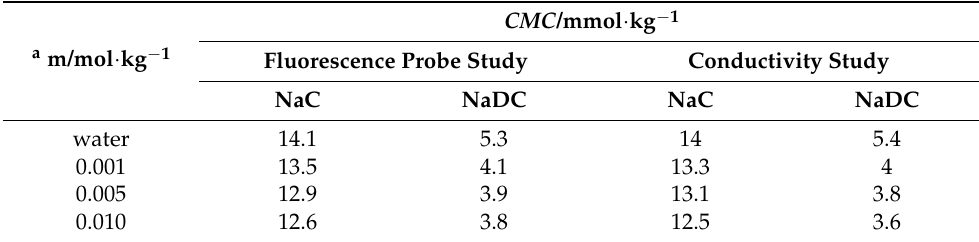
Table 5. CMC of NaC and NaDC in studied concentration of aqueous glycyl dipeptide at room temperature and experimental pressure, p = 0.1 MPa.